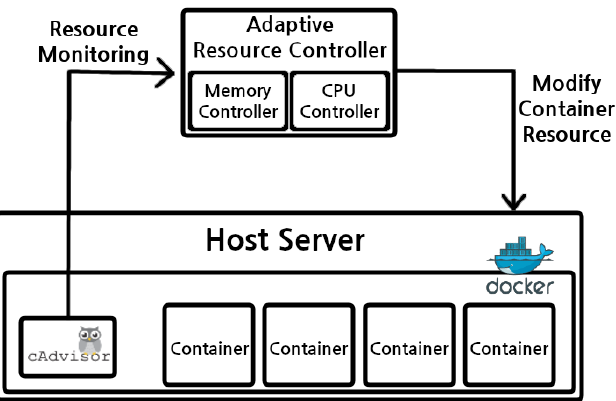
Figure 1. Adaptive resource management scheme in container-based cloud environments: the Adaptive Resource Controller periodically adjusts CPU and Memory limits of running containers if necessary, based on the monitored resource usages and pre-defined resource allocation